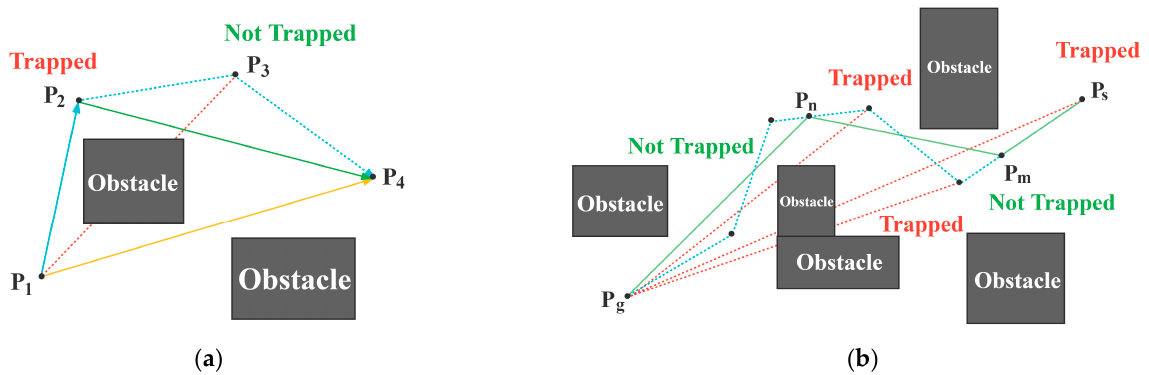
Figure 2. ( a ) Schematic diagram of local optimum; and ( b ) strategies for removing redundant turning points.